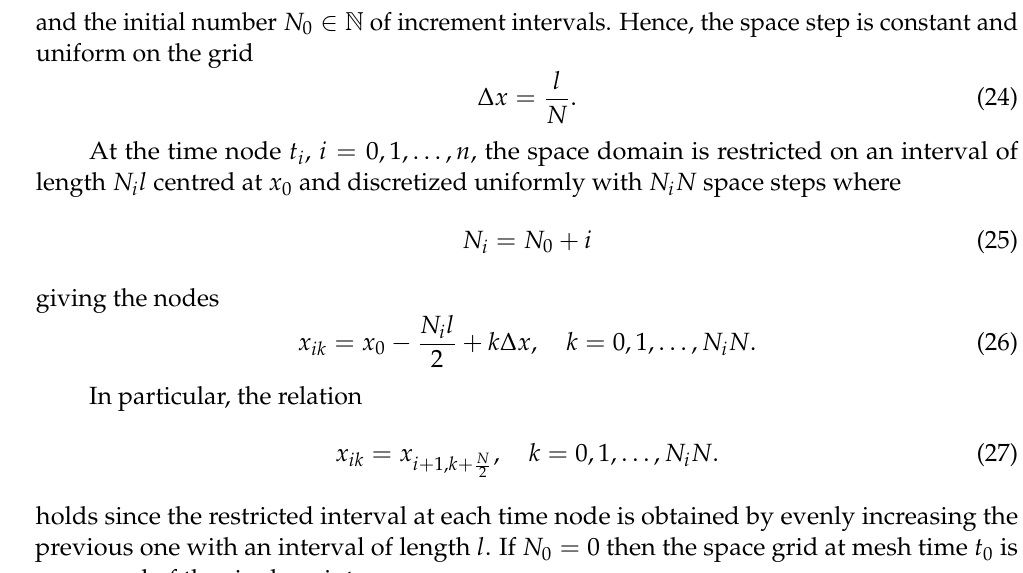
Figure 1: Examples of alternative grids